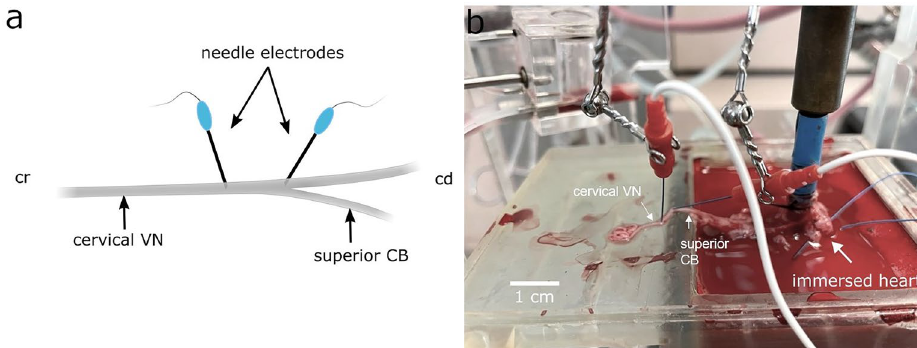
Figure 4. ( a ) Schematic showing the placement of needle electrodes. ( b ) Isolated innervated rabbit heart mounted to the working heart system. A pair of needle electrodes is placed close to the superior cardiac branch (cathode) and cranial to the cervical VN (anode). ECG leads were placed into the right atrium for heart rate detection. cr cranial, cd caudal, CB cardiac branch, ECG electrocardiogram, VN vagus nerve.